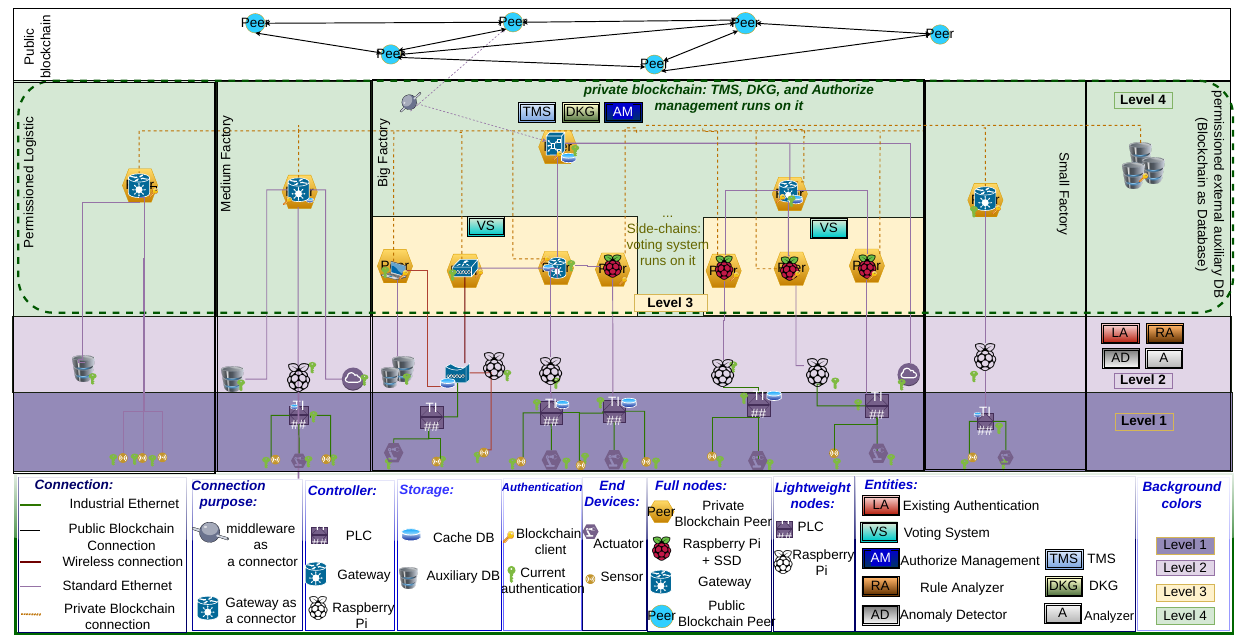
Figure 1. General Schloss